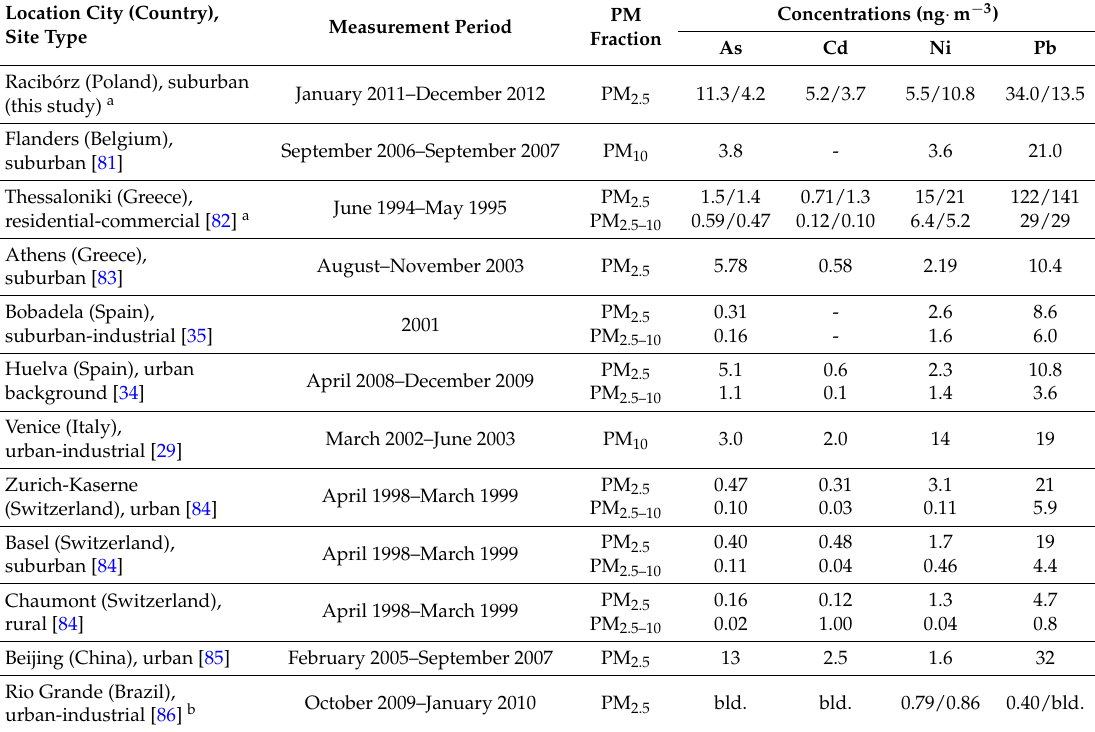
Table 3. The mean concentrations of PM-related As, Cd, Ni, and Pb at various sites in the world. Location City (Country), Site